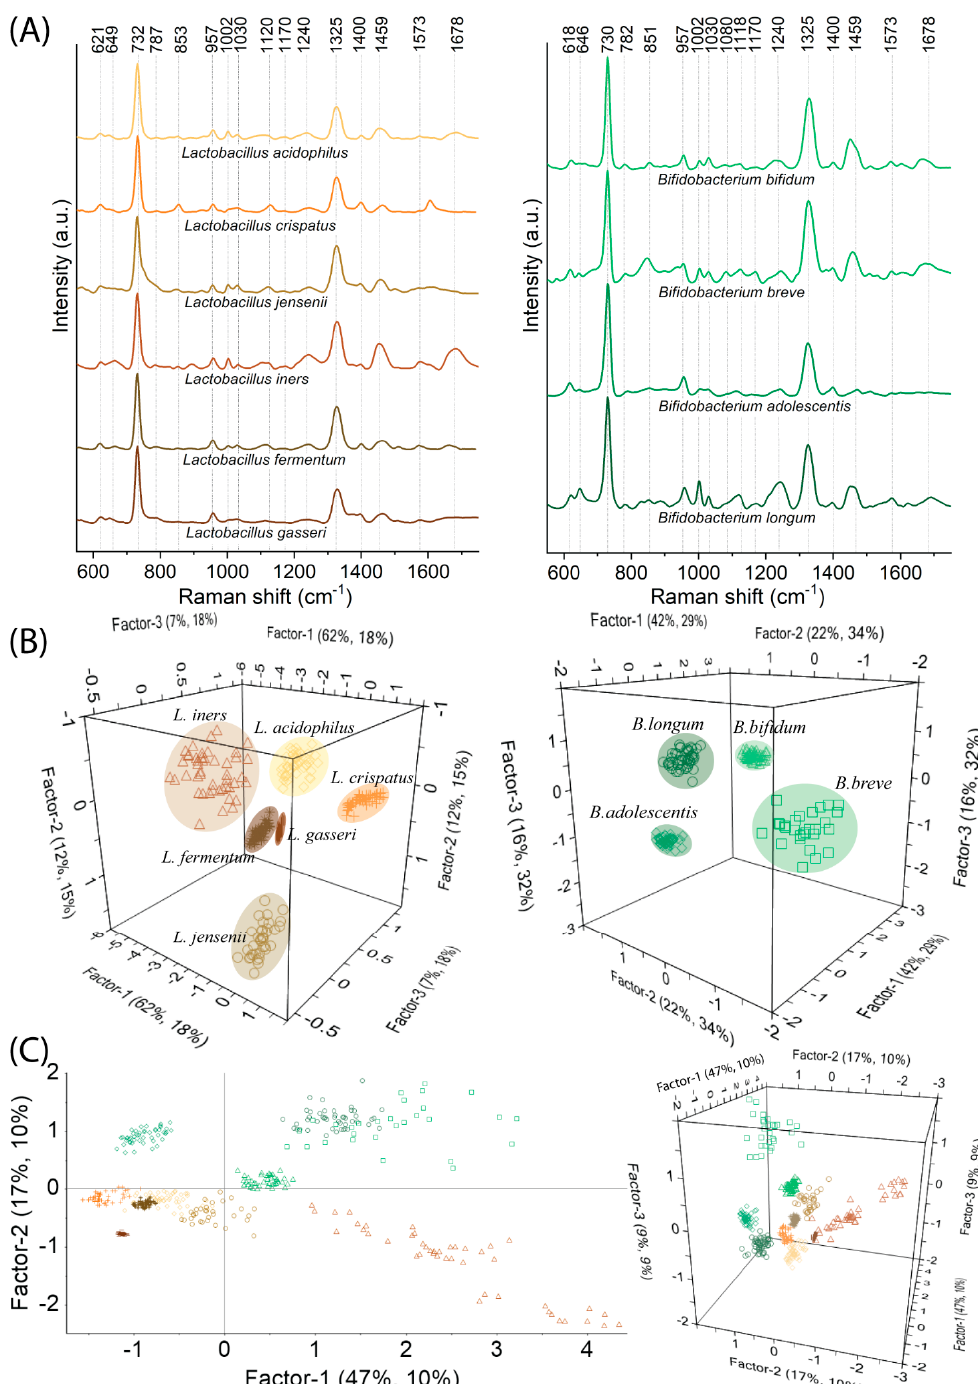
Figure 3. The SERS spectra for Lactobacillus spp. and Bifidobacterium spp. ( A ) and PLSR results in the form of score plots calculated for the following associations: ( B ) Lactobacillus spp. and Bifidobacterium spp. separately (inter-species distinction) and ( C ) Lactobacillus spp. and Bifidobacterium spp. together (intergeneric